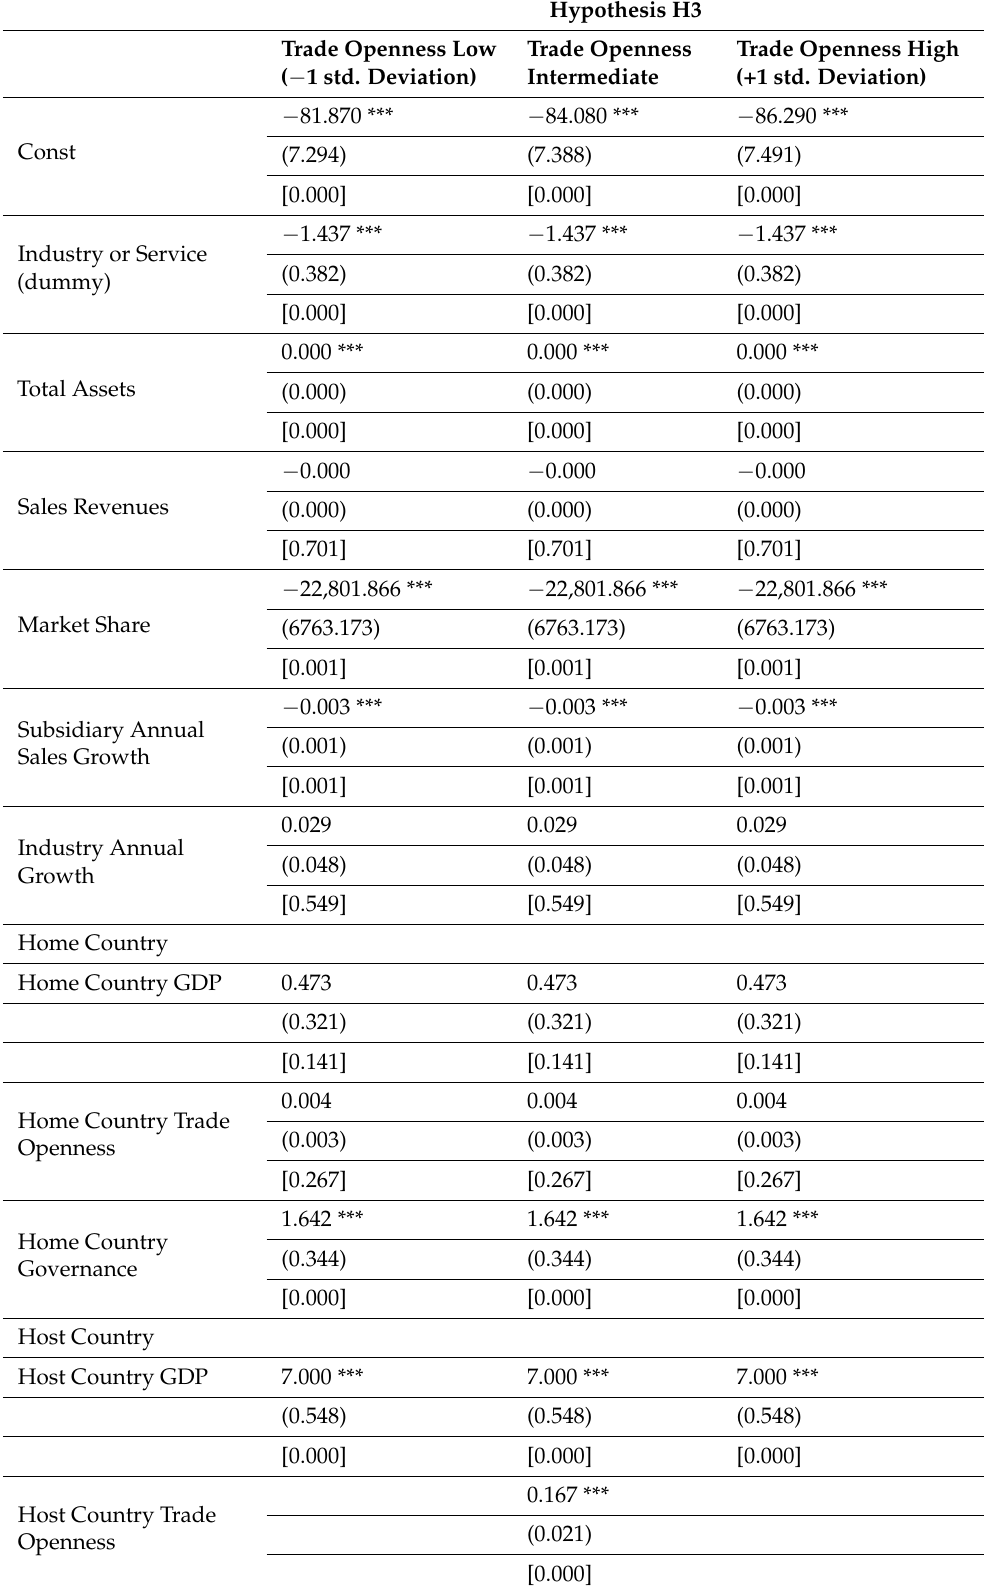
Table 3. The moderating effects of host country trade openness on the relation between CD and